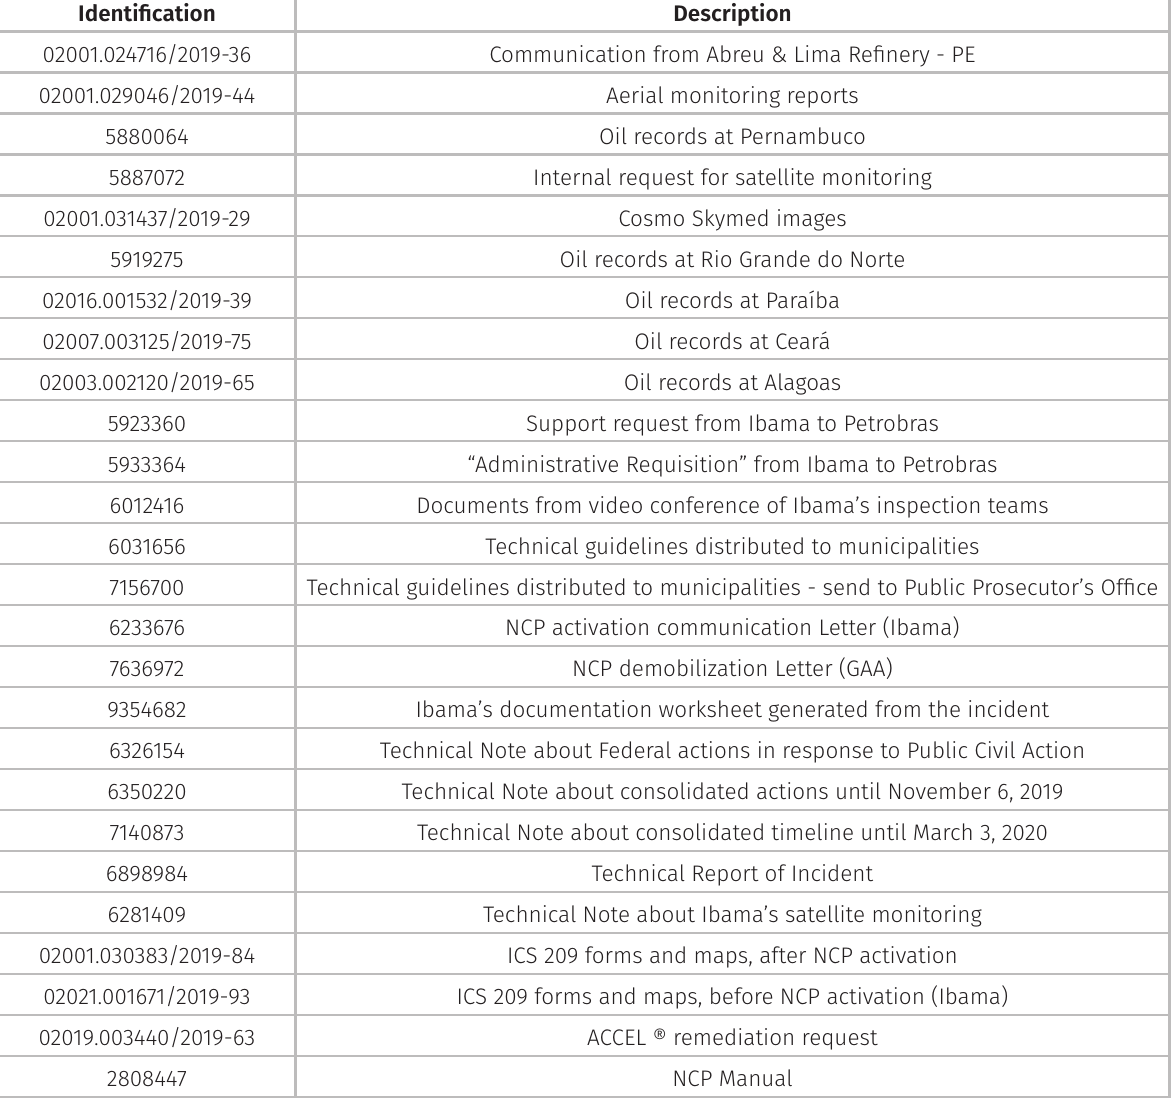
Table I. Official documents obtained through SEI-Ibama (Ibama 2020).